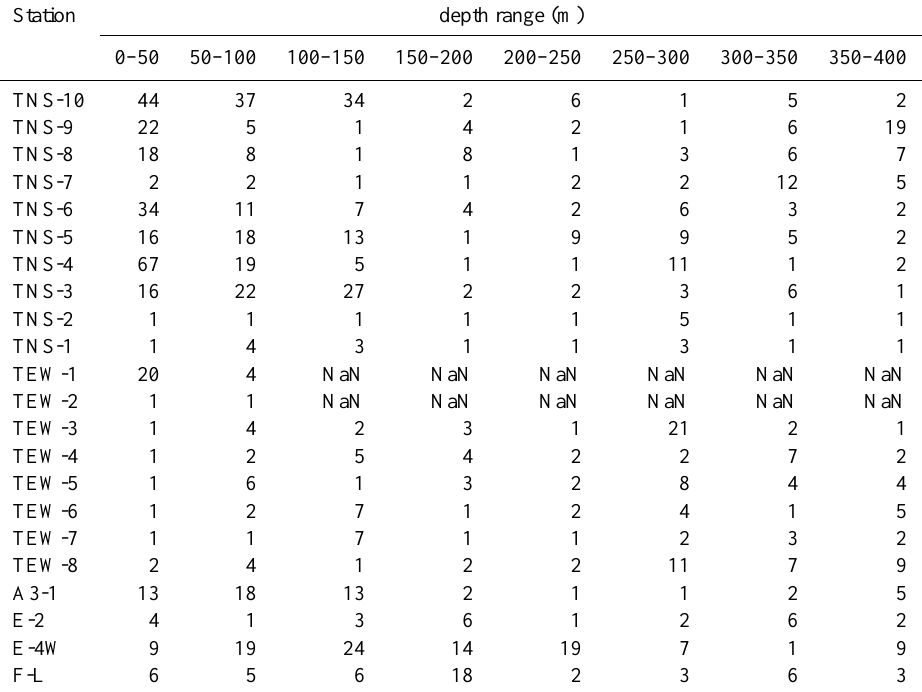
Table 1. Fifty-meter averaged vertical diffusivities (in 10 − 5 m 2 s − 1 ) at KEOPS2 stations estimated from the Thorpe scale method using the Shih parameterization and the R o = 0 . 25